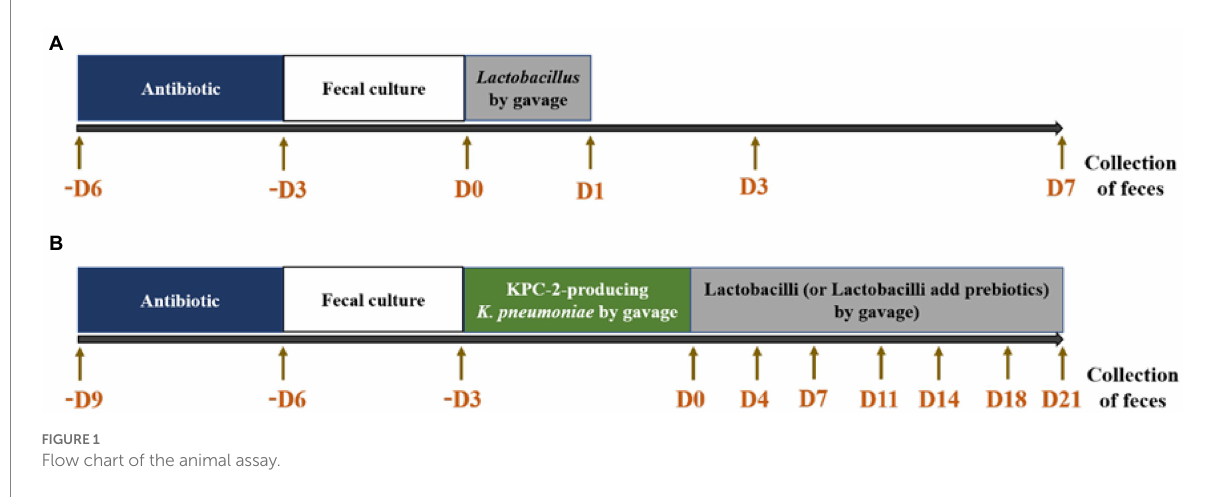
FIGURE 1 Flow chart of the animal assay.